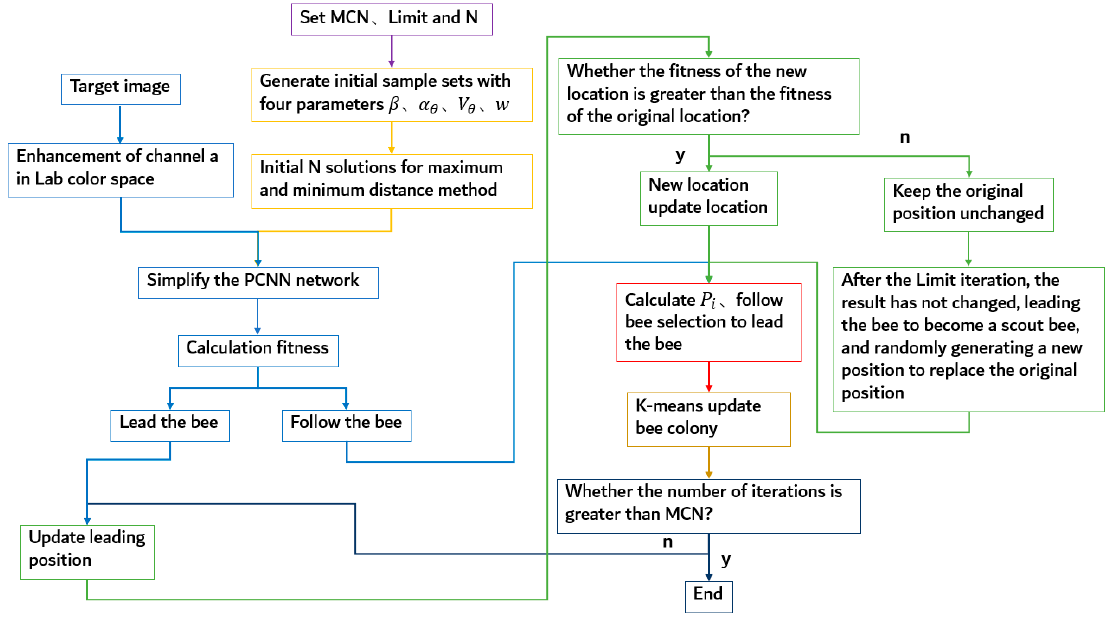
Figure 5. The schematic diagram of improved artificial bee colony (IABC)-K-pulse-coupled neural network (PCNN). The purple frame, light yellow frame, light blue frame, green frame, red frame, dark yellow frame, and dark blue frame correspond to steps (a), (b), (c), (d), (e), (f), and (g), respectively.